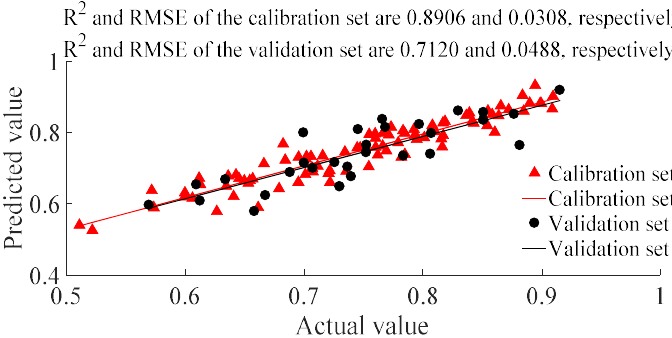
Figure 4. Pomelo water content PLSR detection result based on the SG + MSC data processed spectrum.